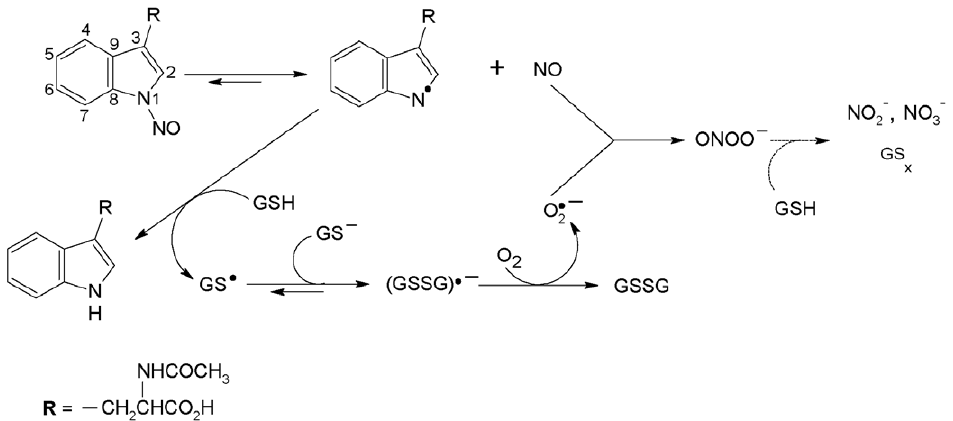
Figure 11. Proposed pathway for the denitrosation of NANT by GSH in the presence of molecular oxygen.